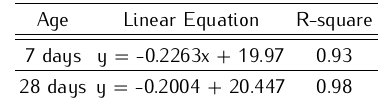
Table 6. Linear equations and regression values at 7 and 28